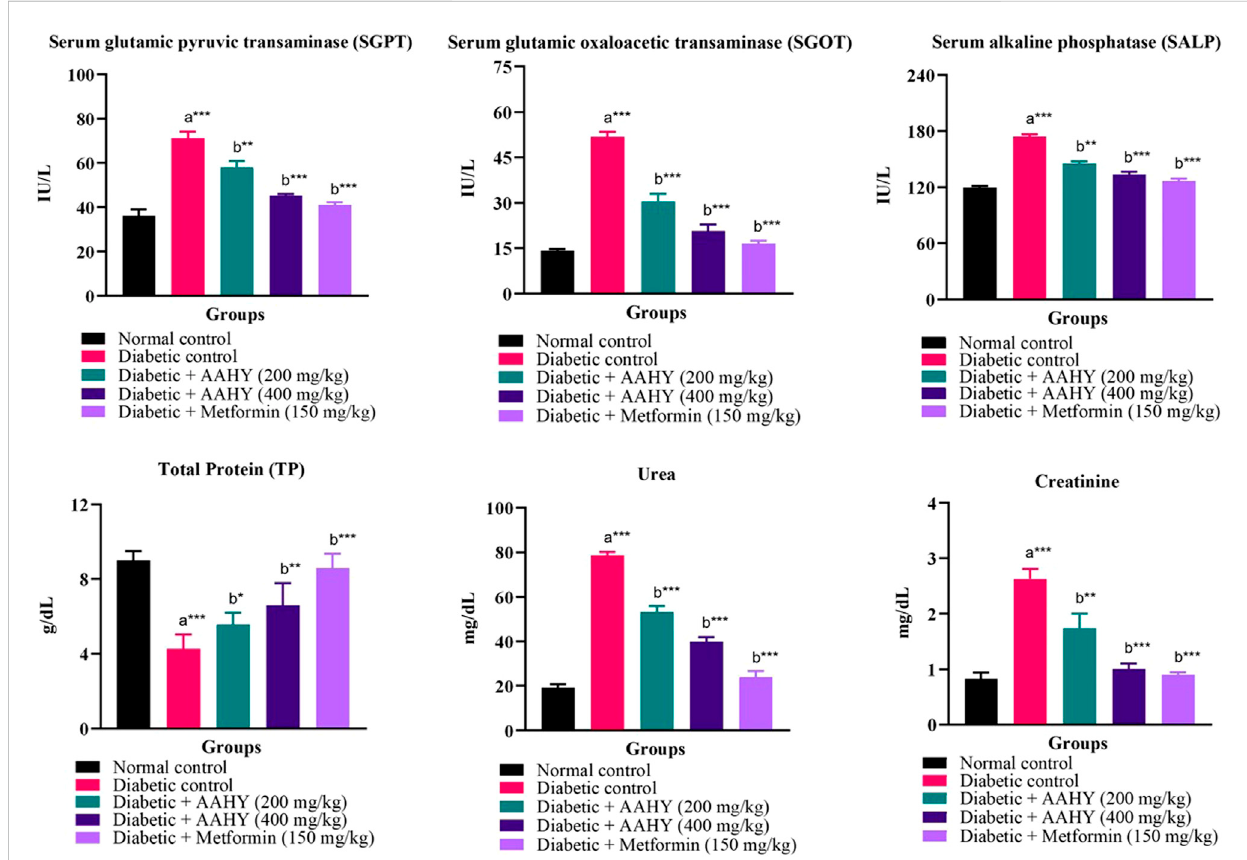
FIGURE 5 EffectoftheAAHYextractonserumbiochemicalparameters.Theerrorbardenotesmean±SEM,and n =6foreachgroup.arepresentsthediabetic controlgroupversusthenormalcontrolgroup,andbrepresentsthediabeticcontrolgroupversustreatedgroups.* p < 0.05,** p < 0.01,and*** p < 0.001. SEM: standard error of